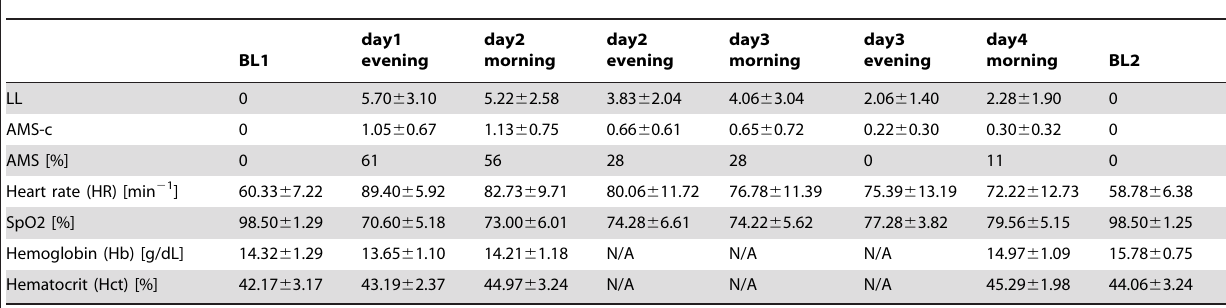
Table 1. Overview of systemic parameters of THAO study participants.